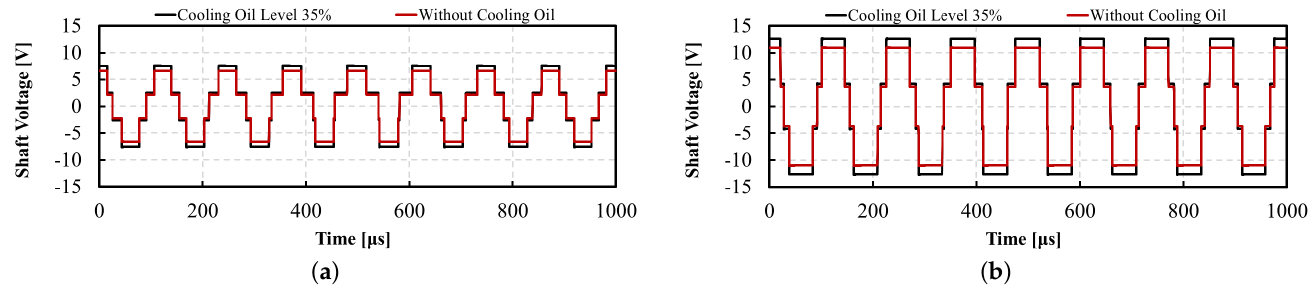
Figure 15. Simulated shaft voltage waveform at ( a ) 360 V and ( b ) 600 V.